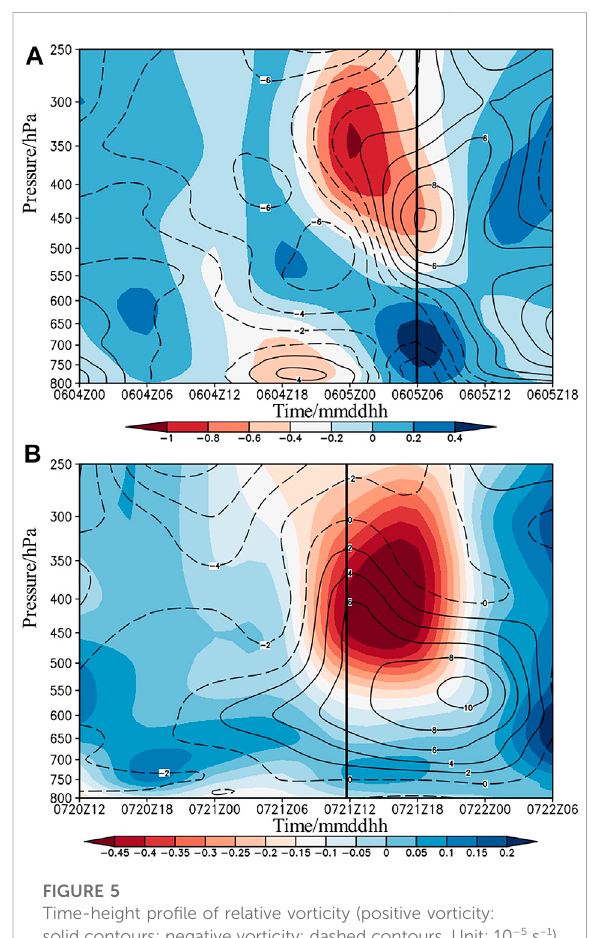
FIGURE 5 Time-height pro fi le of relative vorticity (positive vorticity: solid contours; negative vorticity: dashed contours, Unit: 10 – 5 s − 1 ) and vertical velocity (shaded, Unit: Pa · s − 1 ) of the rainstorm center (A) (100 ° E, 40 ° N) in Case 2012; (B) (106 ° E, 35 ° N) in Case 2013) (the vertical line is the time when vortex passes through rainstorm